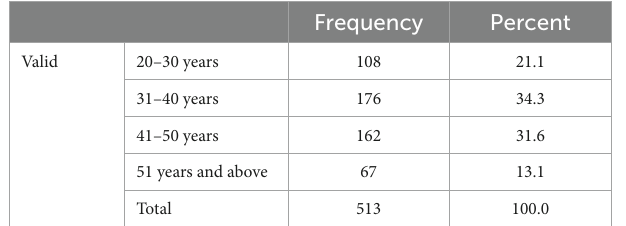
TABLE 2 Age group of the study sample.